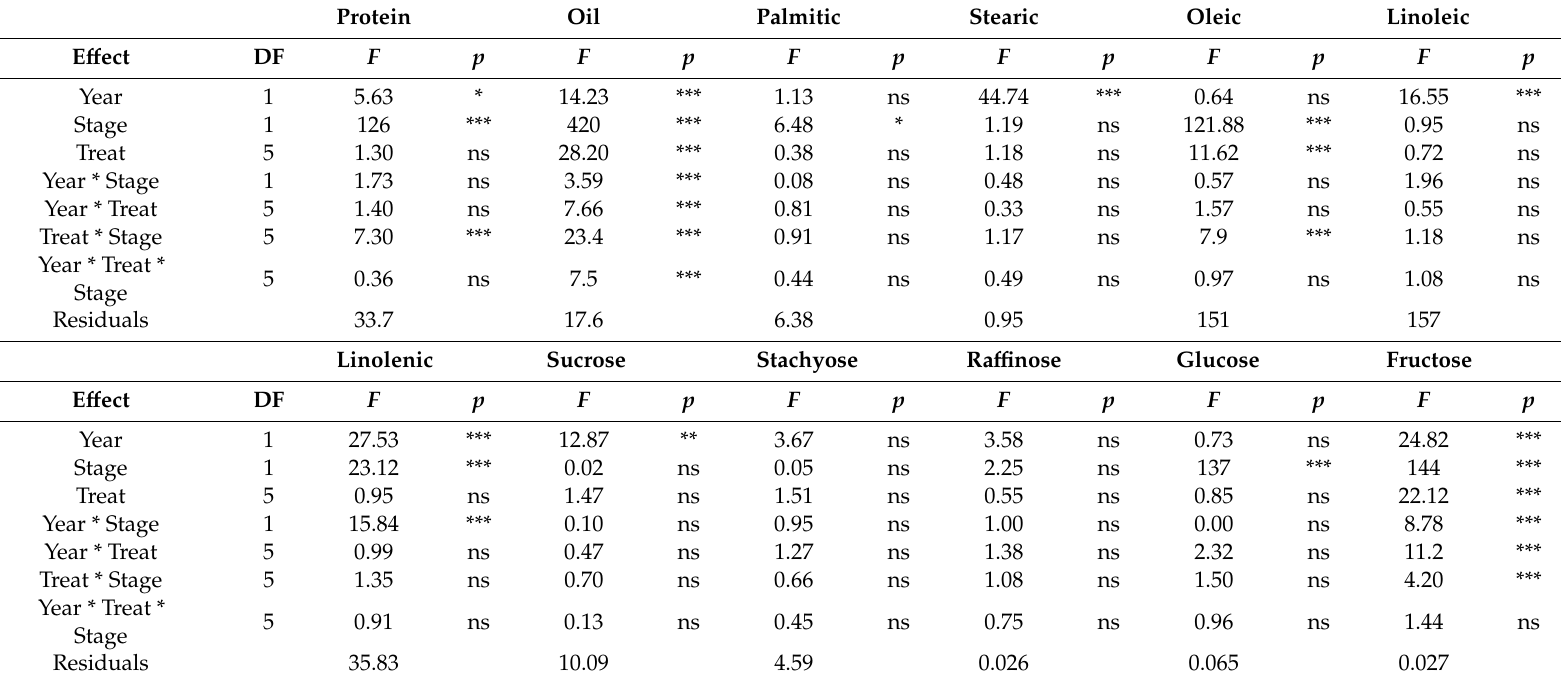
Table 1. Analysis of variance ( F and p values a ) for the e ff ects of harvest aid application (treatments, Treat: paraquat, paraquat + carfentrazone-ethyl,